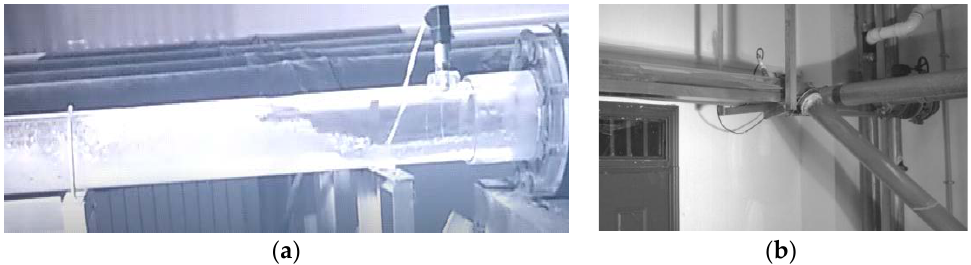
Figure 5. Complete flow interruption state: ( a ) the complete flow interruption state at Point 1; and ( b ) the complete flow interruption state at Point 2.